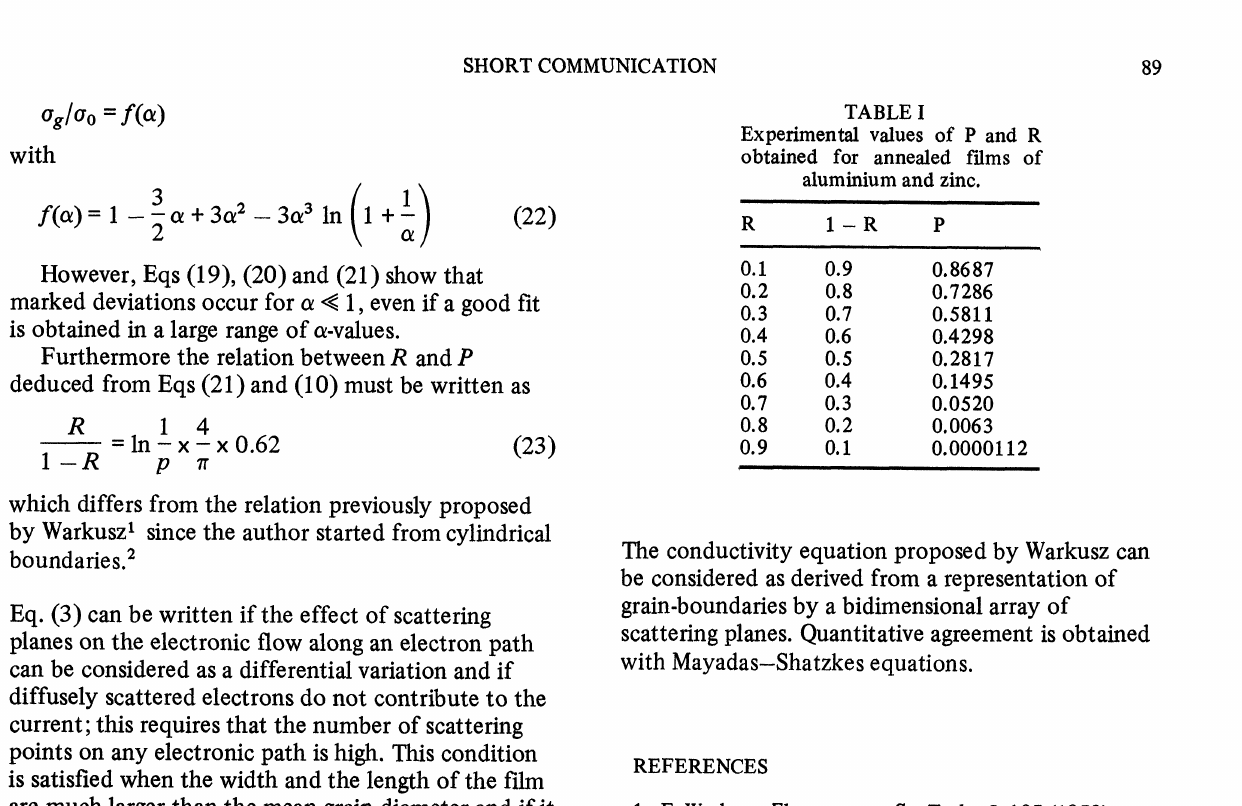
obtained for annealed films of aluminium and